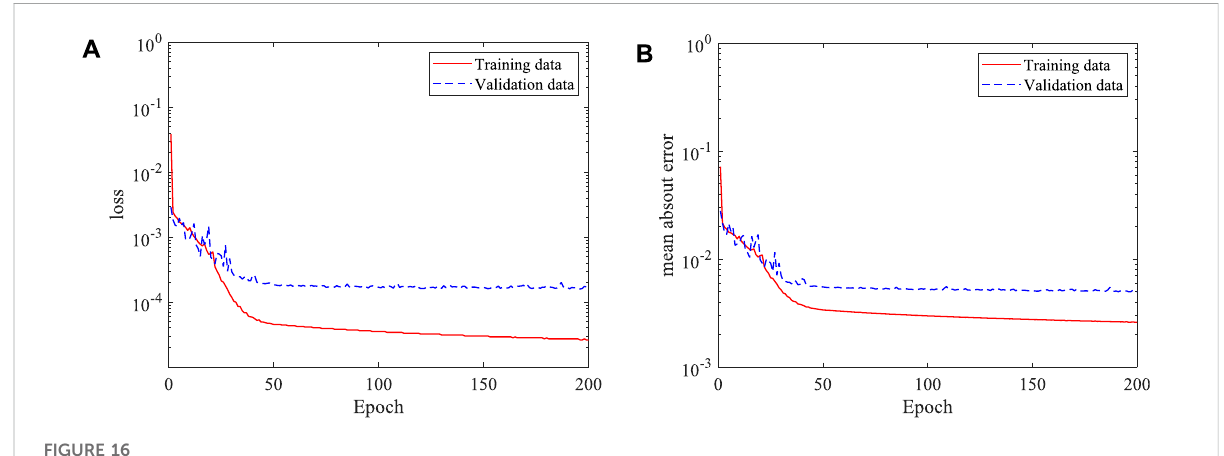
FIGURE 16 Histories of loss and mean absolute error of the DNN for asymmetric stenosis: (A) loss, and (B) mean absolute error.